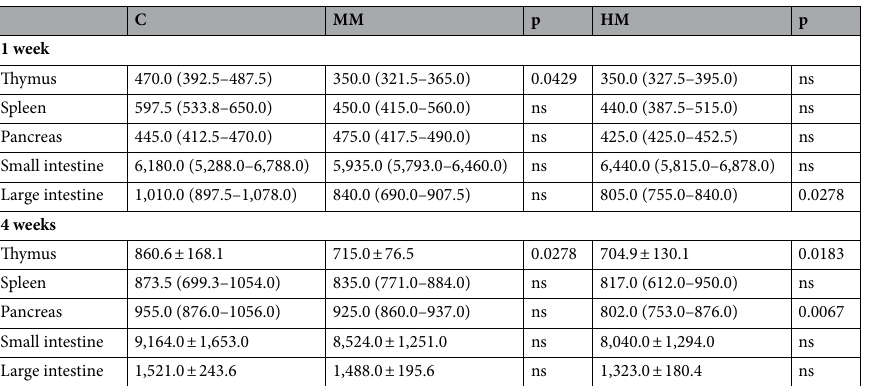
Table 1. Weights (mg) of organs from rats weaned at 3 weeks of age and fed control (C), medium Maillard (MM) or high Maillard (HM) containing diets for 1 or 4 weeks. Values from rats fed 1 week are expressed as median (interquartile range), n = 4. Kruskal–Wallis followed by Dunn´s multiple comparison test. Values from rats fed 4 weeks are expressed as mean ± SD or median (interquartile range), n = 10–11. One-way ANOVA followed by Dunnett´s multiple comparison test or Kruskal–Wallis followed by Dunn´s multiple comparison test), p = p value as compared to C, ns = no significant differences compared to